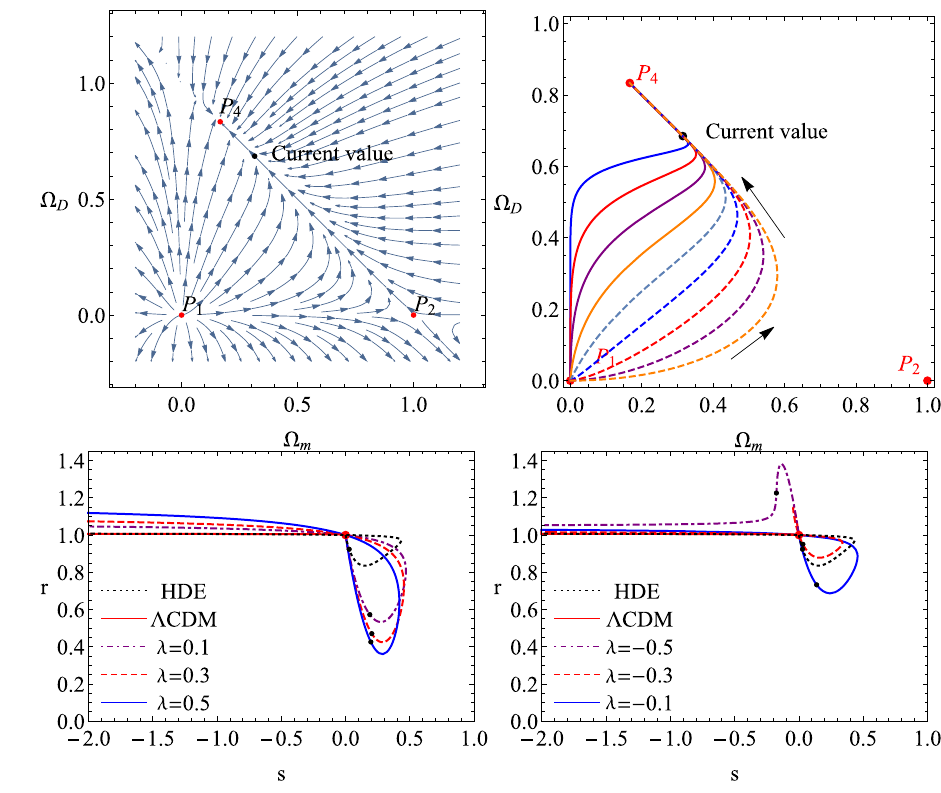
Fig. 23 Phase space trajectories for IBHDEHL with λ = 1 . 2. The left panel is plotted for the behavior of attractor P 4 with (cid:5) = 0 . 8, the right panel is plotted for the evolution trajectories with different value of 0 < (cid:5) < 1